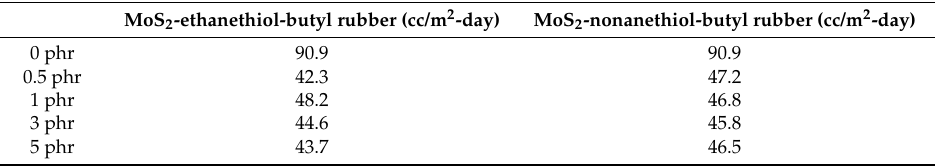
Table 1. Oxygen transmission rates (OTRs) of MoS 2 -butyl rubber